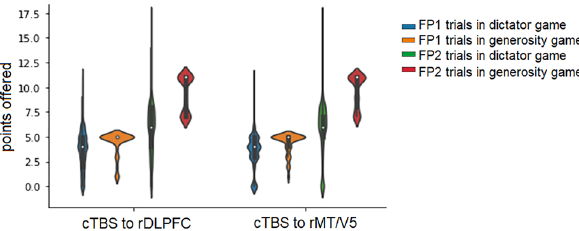
Figure 3. Allocations to recipients in the dictator game and offered pie size in the generosity game in the FP1 and FP2 trials. The blue violin plot indicates the data points corresponding to the FP1 trials in the dictator game, the orange violin plot corresponds to the FP1 trials in the generosity game, the green violin plot corresponds to the FP2 trials in the dictator game, and the red violin plot corresponds to the FP2 trials in the generosity game. The data corresponding to cTBS of the rDLPFC are depicted on the left, and the data corresponding to cTBS of the MT/V5 are depicted on the right. Note : The top and bottom of the violin plot indicate the maximum and minimum, respectively, the lower bar of the boxplot denotes the first quartile (Q1), the white dot denotes the median, and the higher bar of the boxplot denotes the third quartile